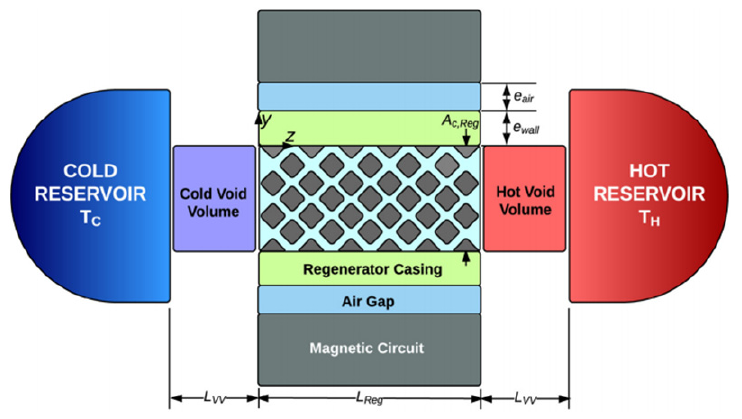
Figure 23. Geometry considered by the model including volumes and adjacent domains [81].